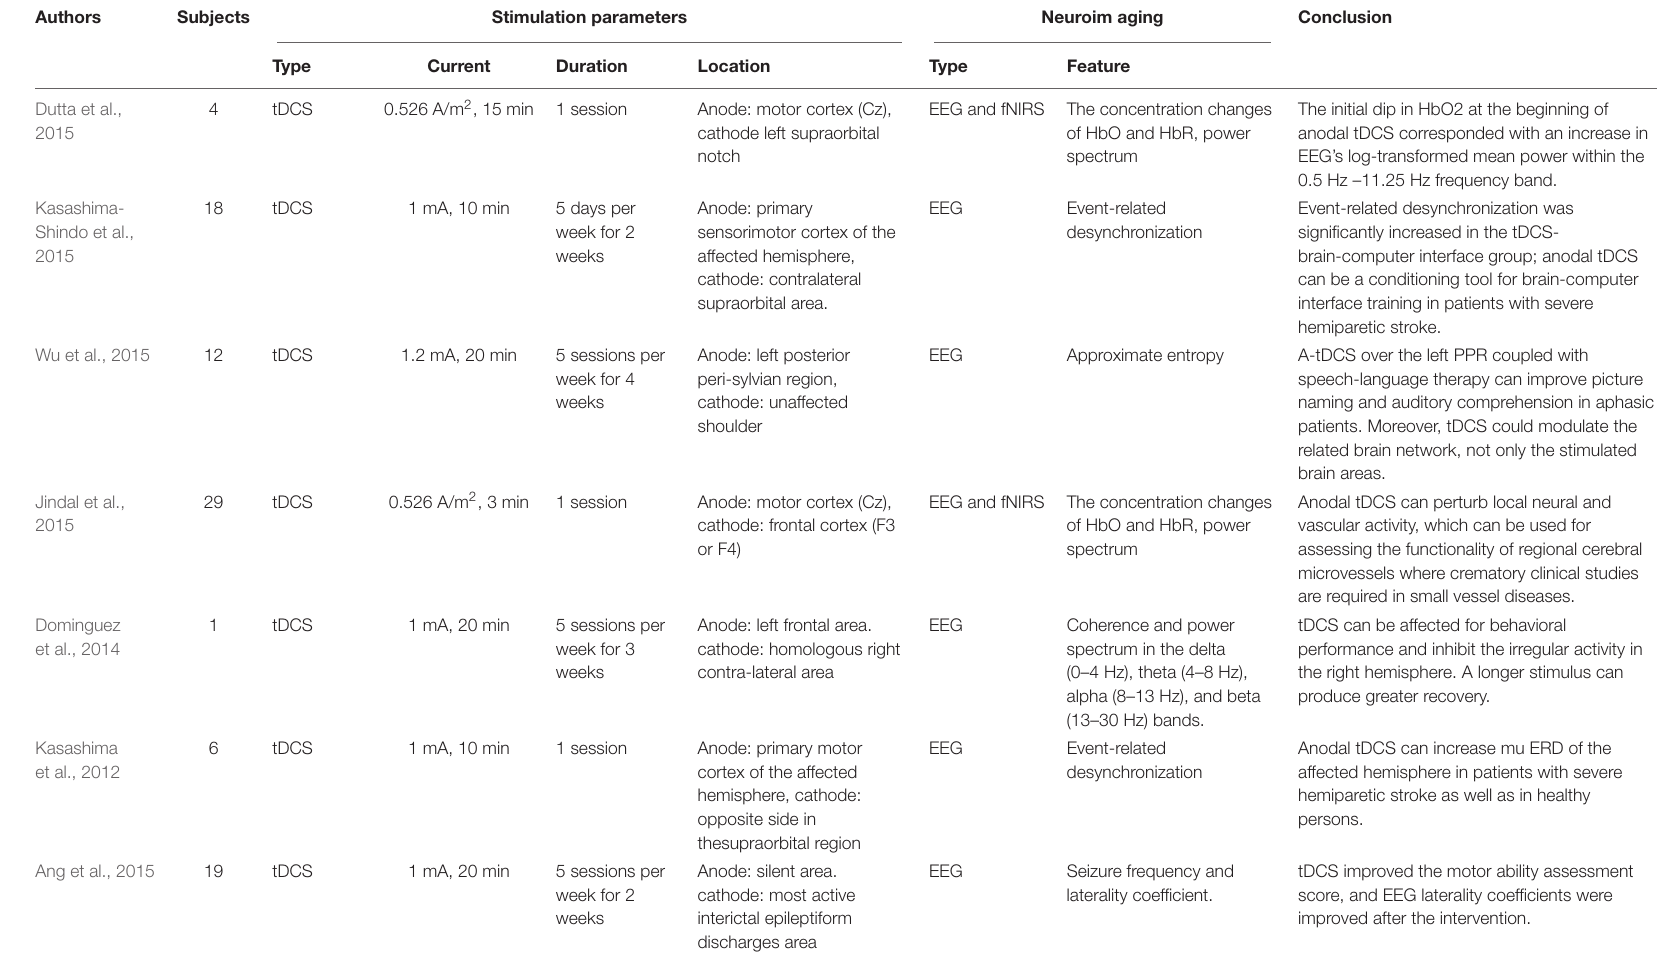
Seizure frequency and laterality